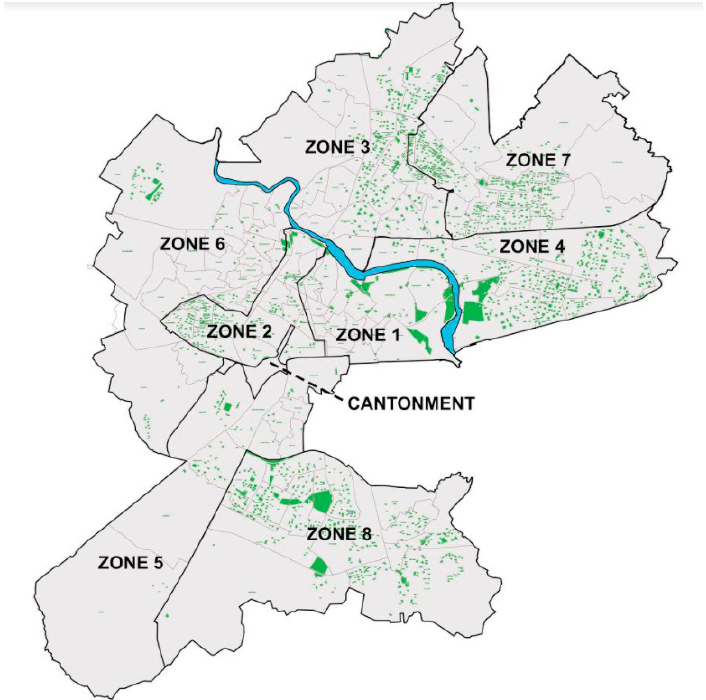
Figure 2. Regional Open/Green Spaces, Lucknow City